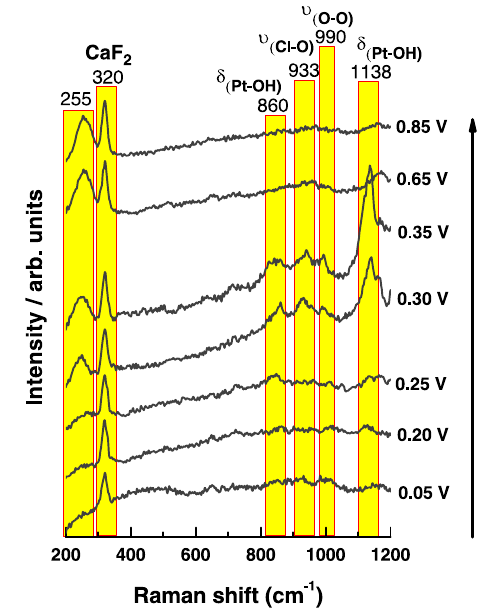
Fig. 4 Raman spectra of the hydroxyl phase at low potentials on Pt(311). Potential dependent in situ SHINERS spectra of Pt(311) electrode in 0.1 M HClO 4 electrolyte purged with Ar. The different Raman bands are highlighted by the yellow